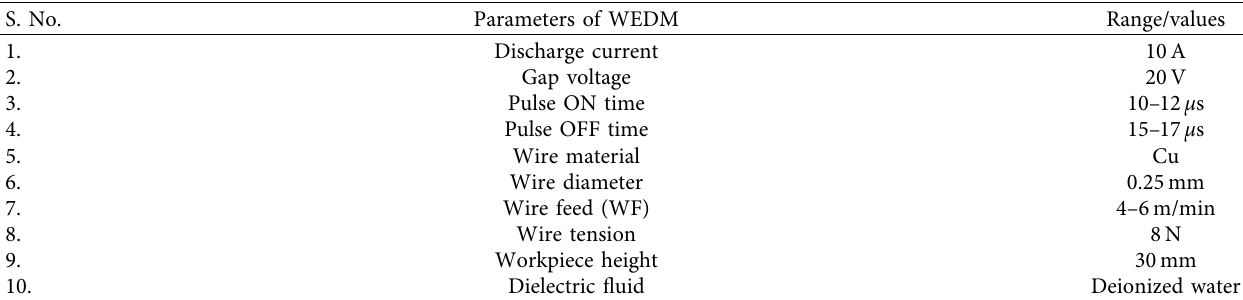
Table 4: Key features of selected WEDM machine.